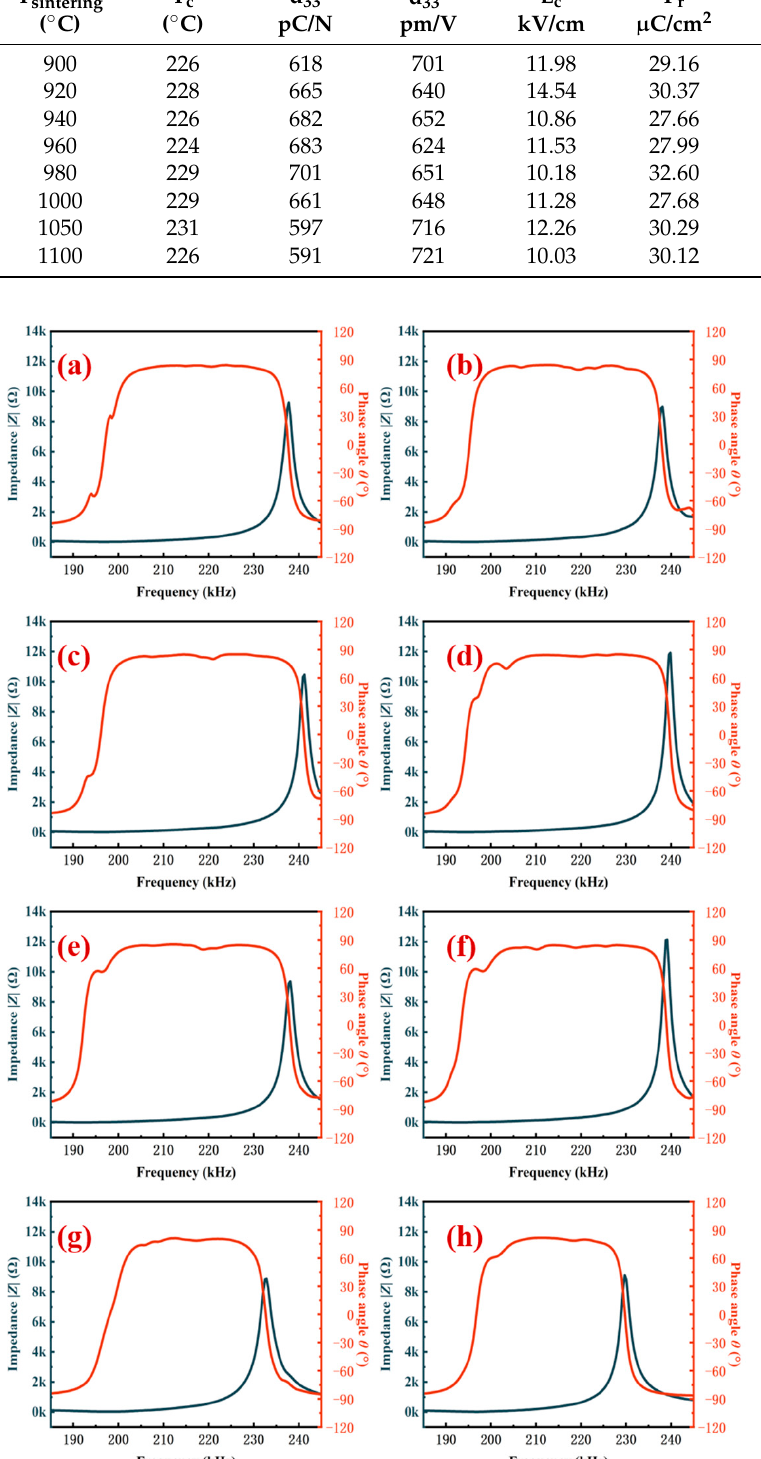
Figure 4. Impedance plots of the 0.2 wt% Li 2 CO 3 -modified ceramics: ( a ) 900 °C sintered; ( b ) 920 °C sintered; ( c ) 940 °C sintered; ( d ) 960 °C sintered; ( e ) 980 °C sintered; ( f ) 1000 °C sintered; ( g ) 1050 °C sintered; ( h ) 1100 °C sintered.